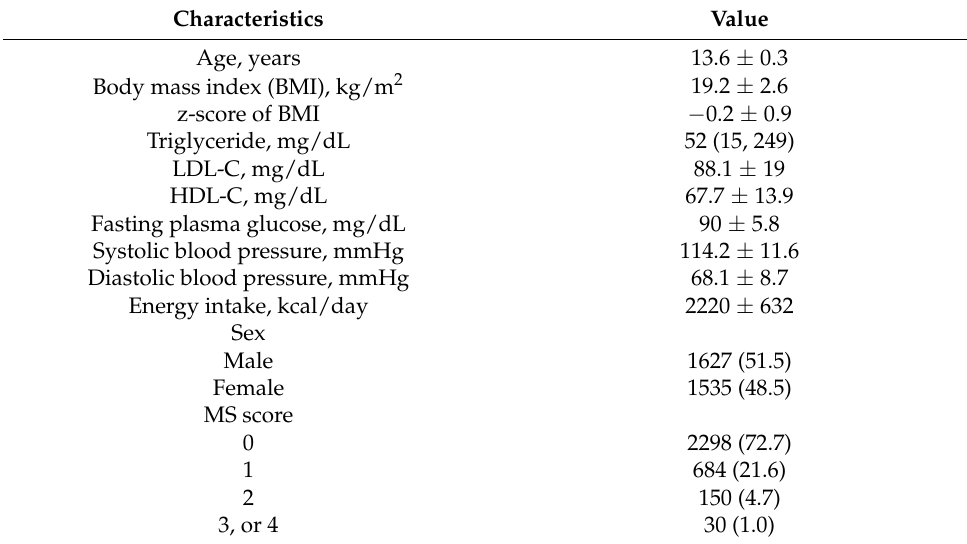
Table 1. Characteristics of the analyzed participants ( n =